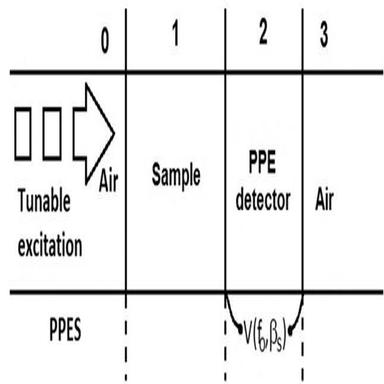
Model of the experimental cell in PPES detection configuration.